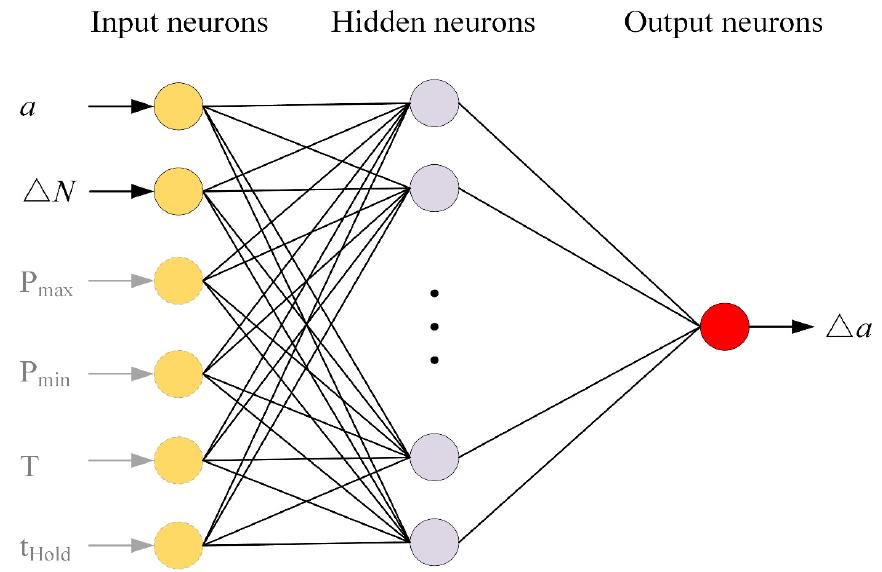
Figure 3. ( a ) Schematic diagram of NN structure for NNIL method and ( b ) the way to construct dataset during testing process.